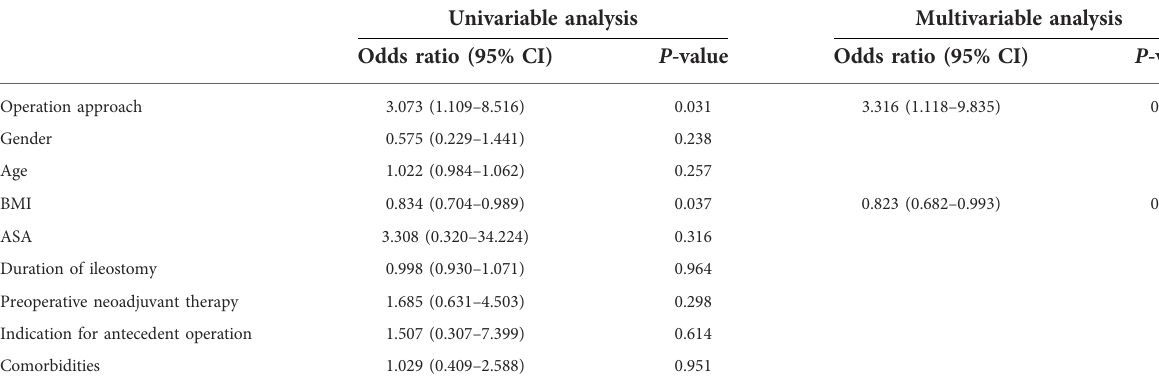
TABLE 3 Logistic regression analysis of potential factors related to postoperative